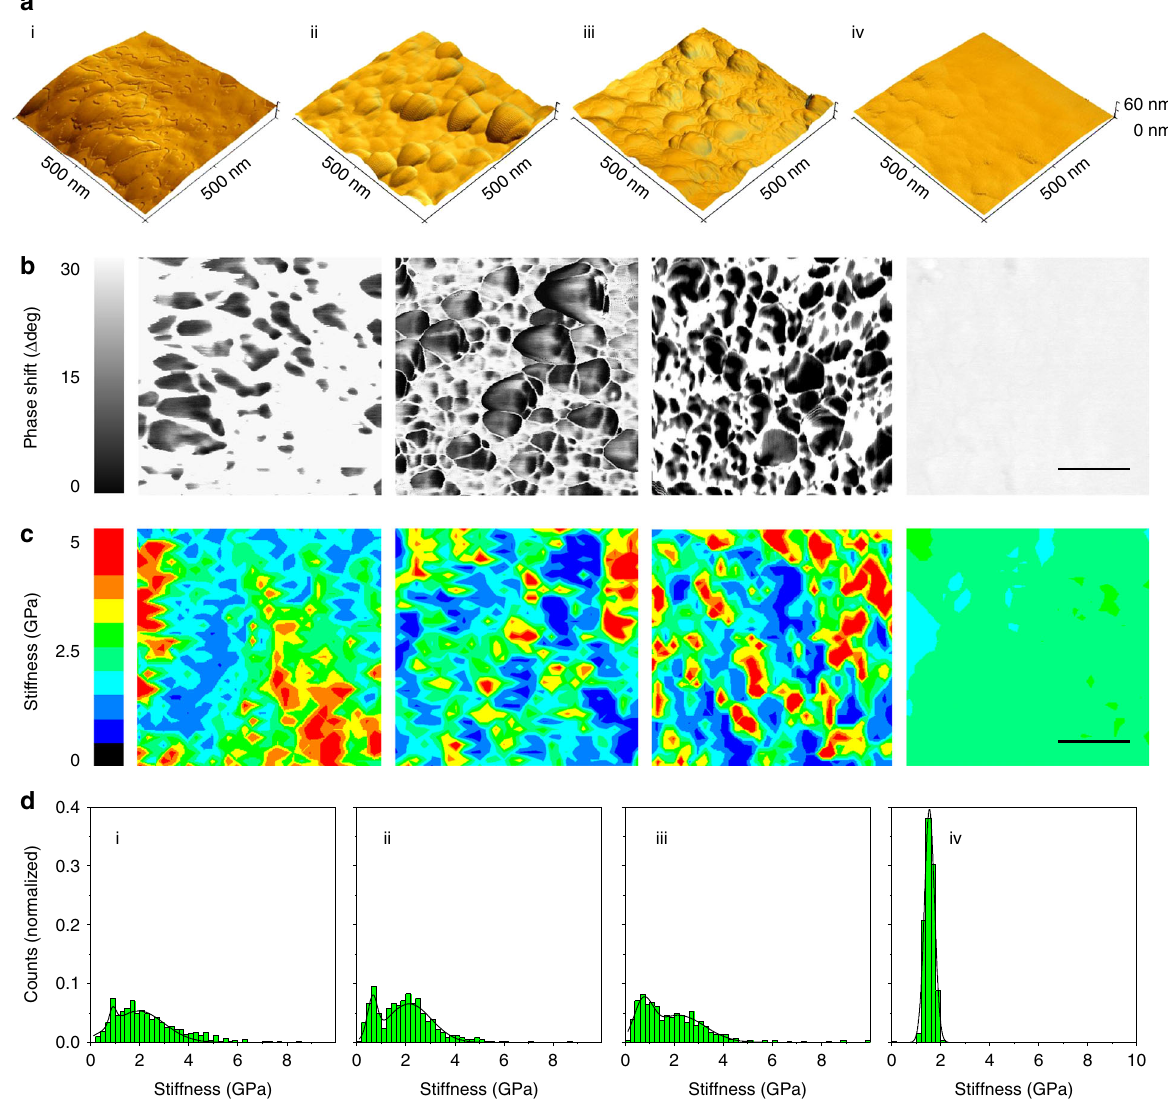
Fig. 3 Nanomechanical investigations of the cuticle granules. All panels labeled with (i) represent M. galloprovincialis , (ii) M. californianus , (iii) S. bifurcatus , and (iv) M. capax . a High-resolution AFM topographical renderings of the abraded, exposed cuticles. b Phase shift images of AFM renderings in a (scale bar = 150 nm). c The granular structures in this channel are discernible by phase shifts to lower degrees. Corresponding color-coded force spectroscopy maps (32 × 32 pixels, scale bar = 150 nm) across these regions show a distinct link between the nanomechanical behavior and phase shifts. d Summary of binned and fi tted stiffness